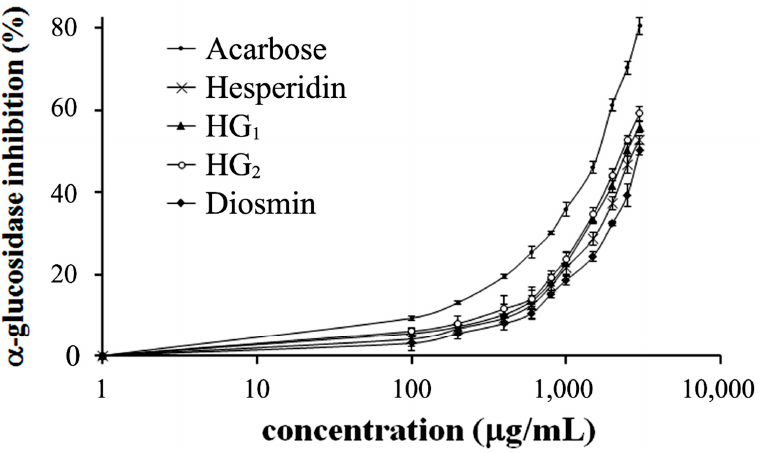
Figure 6. Inhibitory effect of hesperidin, hesperidin glycosides, diosmin and standard acarbose on α -glucosidase from rat intestinal acetone powder. Data shown are mean ± SD of three independent experiments.